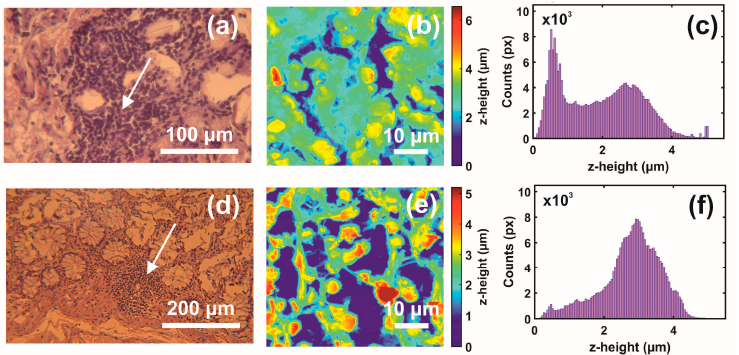
Figure 2. Optical and AFM images and z -height distribution of human CRC histological metastatic/non-metastatic sections. ( a ) Optical image (40 × ) of a metastatic section (0.17 mm × 1.73 mm). ( b ) AFM image of metastatic tissue at the specified point of the image in ( a ) (arrow). ( c ) The z -height distribution from the AFM image shown in ( b ). ( d ) Optical image (20 × ) of non-metastatic histological section. ( e ) AFM image of non-metastatic tissue at the specified point of the image in ( d ) (arrow). ( f ) The z -height distribution from the AFM image shown in ( e